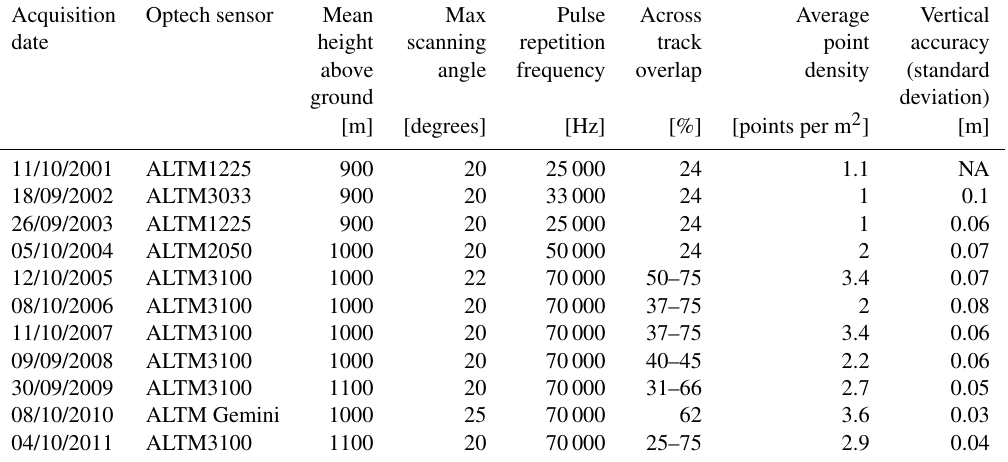
Table 1. Key parameters for the 11 ALS data acquisition campaigns at Hintereisferner from 2001 to 2011. Point density is averaged over the study area, while the horizontal accuracy is calculated based on a flat reference area in the vicinity of the study